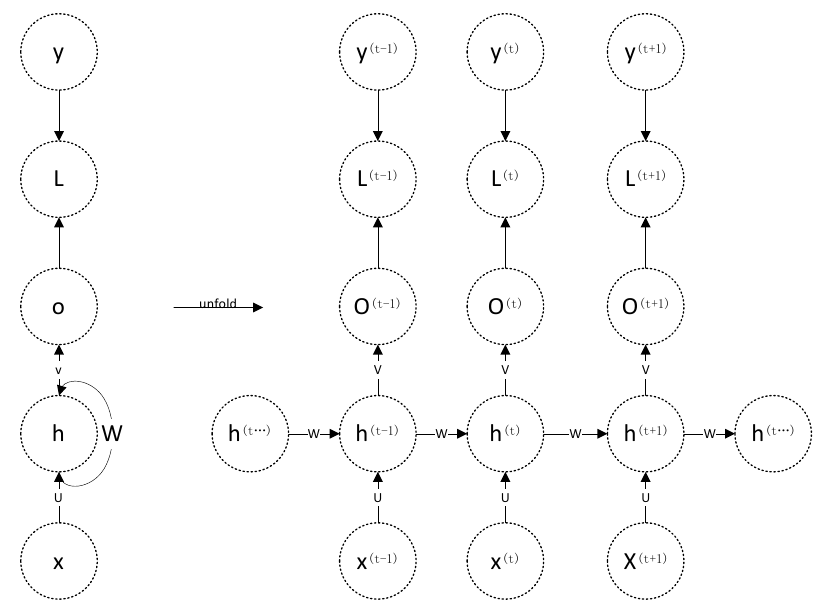
Figure 2. The flow chart of the recurrent neural network (RNN) model.